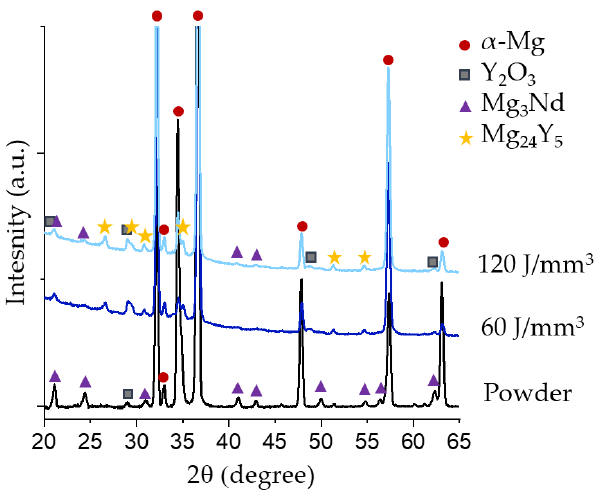
Figure 5. XRD spectra of the WE43 gas-atomized powder and the PBF–LB processed material.